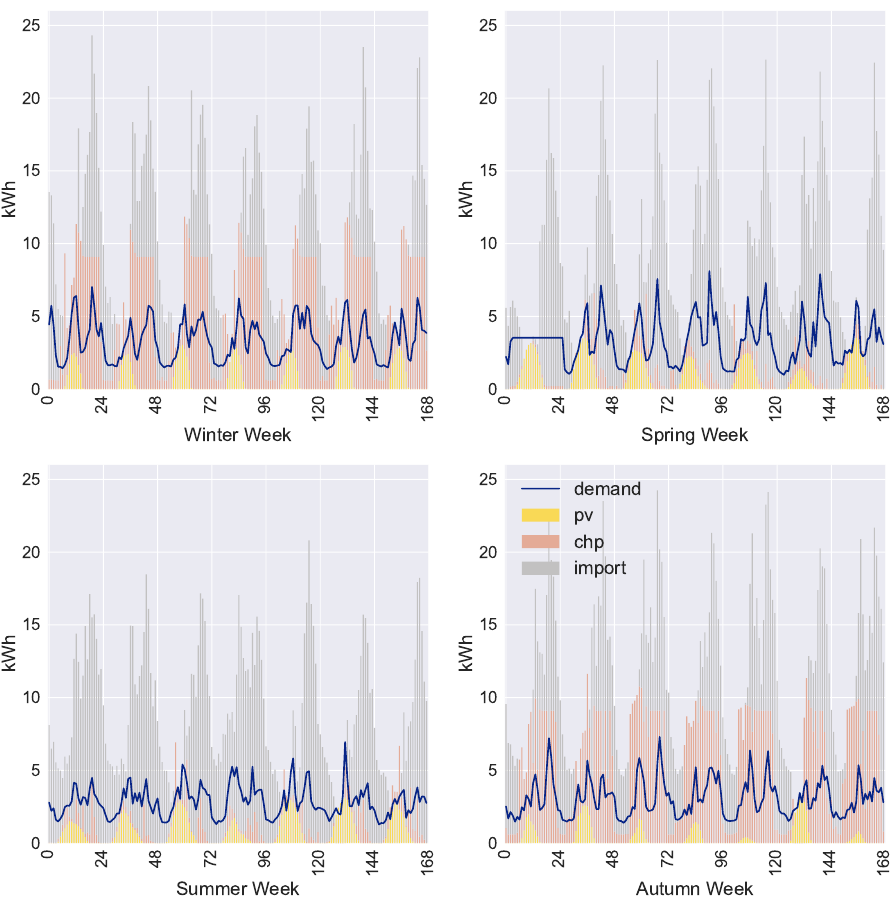
Figure 9. Hourly electricity production of four representative weeks: Location